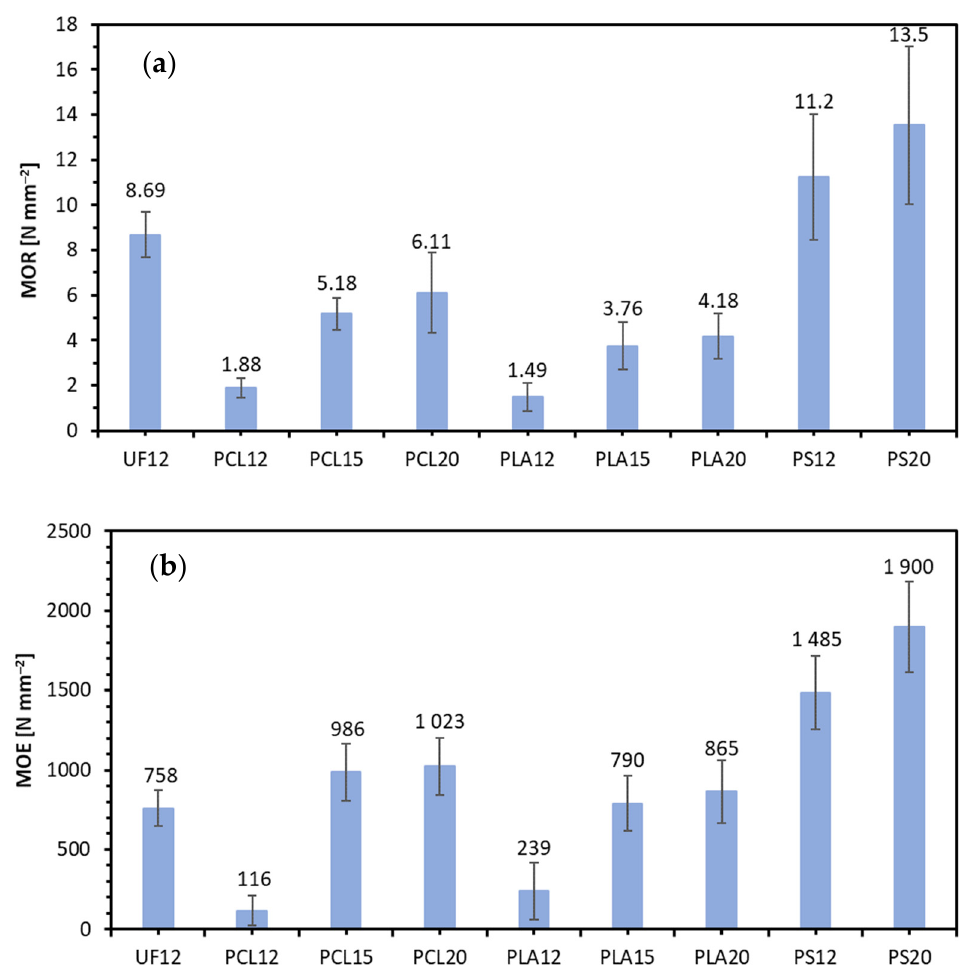
Figure 3. ( a ) Modulus of rupture (MOR) and ( b ) modulus of elasticity (MOE) of tested lignocellulosic composites.